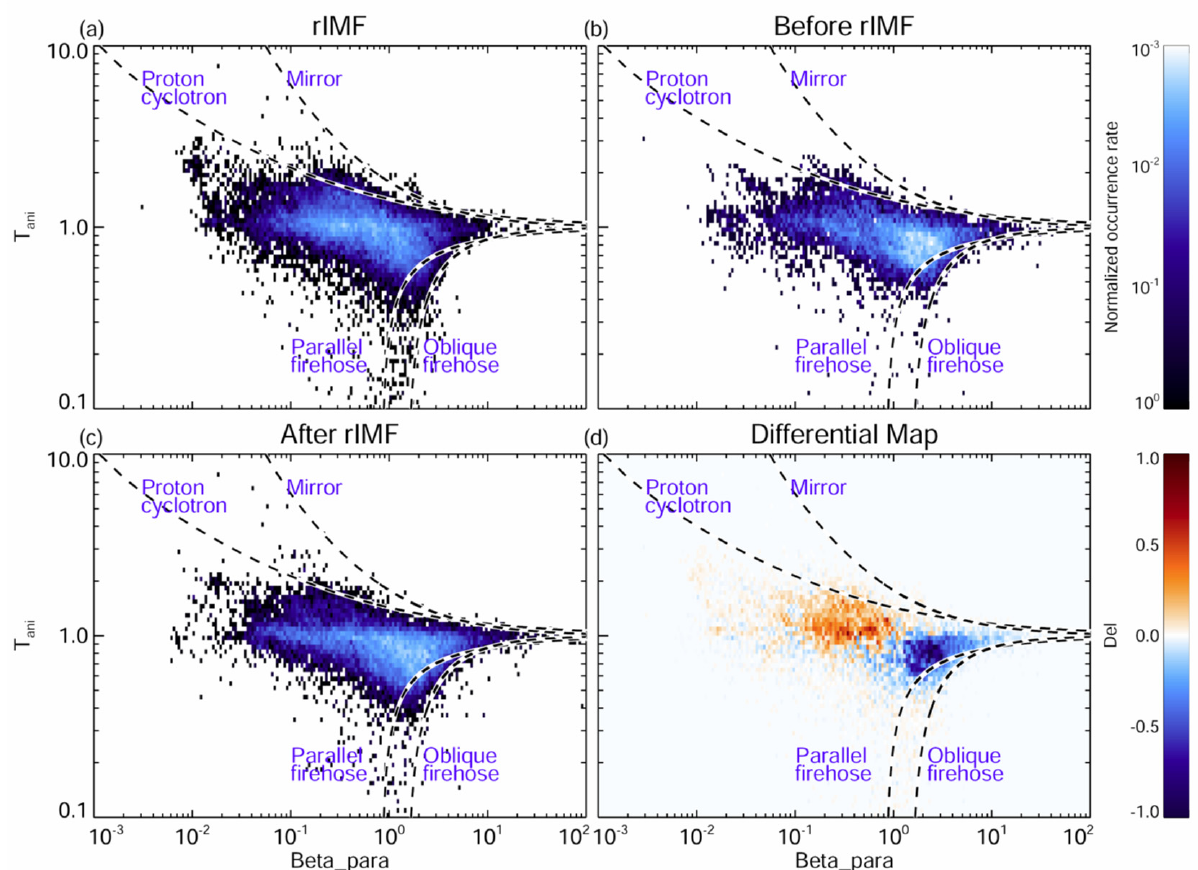
Figure 7. Distribution of T ANI - β (cid:107) P ( a ) in the radial IMF events, ( b ) before, and ( c ) after the events. The dashed curved lines denote the thresholds of Mirror, Proton cyclotron, Parallel firehose, and Oblique firehose instabilities. ( d ) represents the difference between the distribution in the radial IMF events and the mean values of adjacent regions (Del).